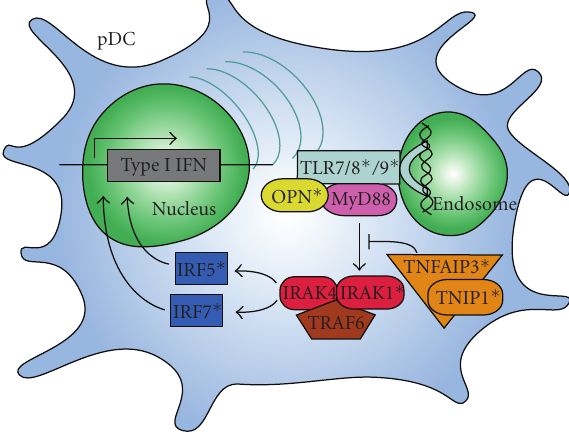
Figure 2: Multiple genes involved in interferon production and regulation are associated with risk for lupus. Shown are components of the signal transduction pathway from TLR stimulation by nucleic acids to IFN production. Genes that have been associated with risk for lupus are marked ( ∗ ). IFN: interferon, IRAK: interleukin-1 receptor-associated kinase, IRF: interferon regulatory factor, MyD88: myeloid di ff erentiation primary response gene 88, OPN: osteopontin, pDC: plasmacytoid dendritic cell, TLR: toll-like receptor, TNFAIP3: tumor necrosis factor alpha induced protein 3, TNIP1: TNFAIP3 interacting protein 1, and TRAF6: tumor necrosis factor receptor-associated factor